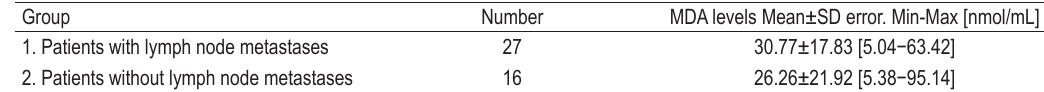
TABLE 2. MDA serum levels in breast cancer patients with and without lymph node metastases